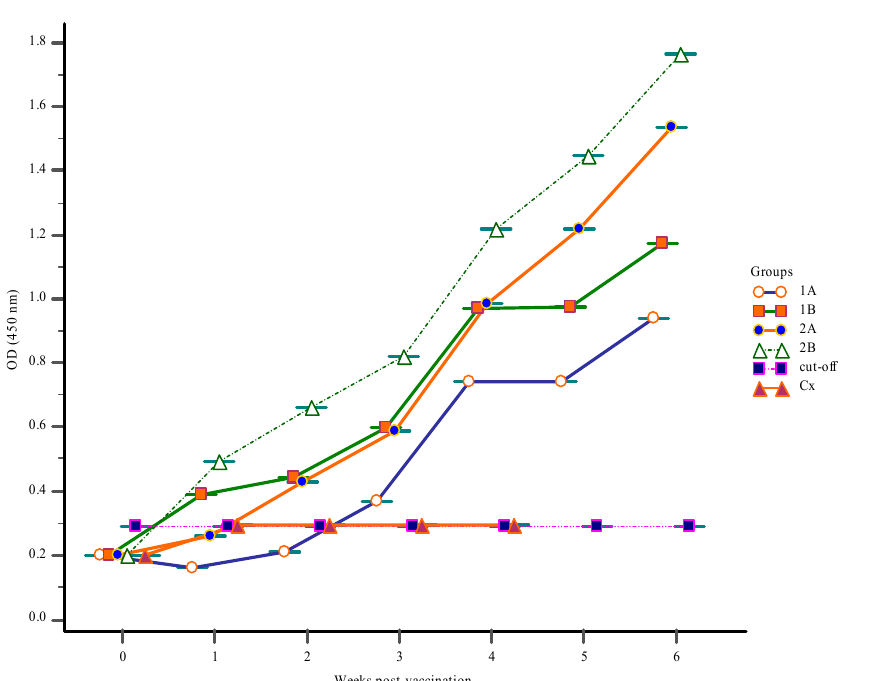
Figure 2. The mucus IgM response following vaccination with feed-based vaccine (1A, 1B, 2A, 2B) and control Group Cx. The first vaccination was done at 0-week post-vaccination (wpv) for groups (1A, 1B, 2A, 2B) with a 1st and 2nd booster vaccination given to Group 2B at 2- and 3-wpv, respectively. All groups were challenged with 10 6 CFU/mL live S. iniae via intra-peritoneum route at 4-wpv.